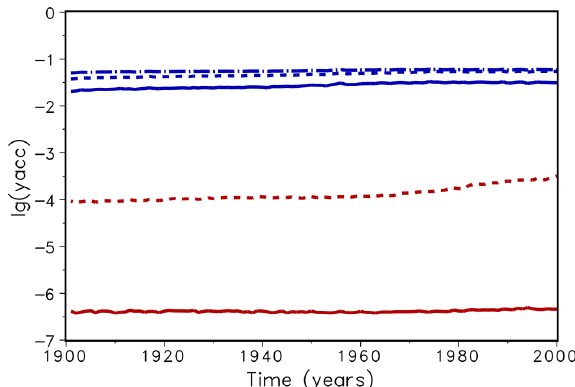
Figure 3. Mean decadic logarithm of the accuracy y acc for bisec- tion (upper lines, blue) and Newton (lower lines, red) for accu- racy x acc = 0 . 01 (dotted) and 0.001 (solid). The dashed–dotted line shows the accuracy of the original version of